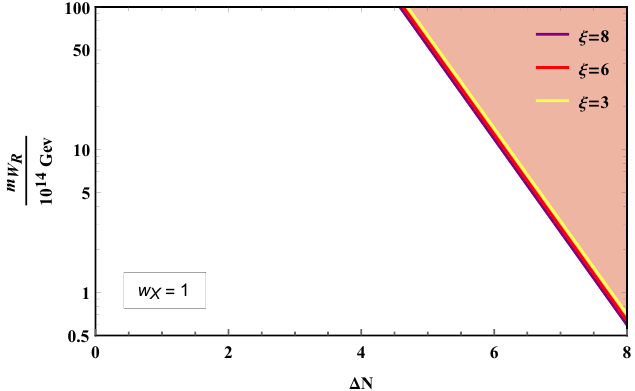
) for different values of ξ that satisfies condition WR = 1 . The accessible region for w X